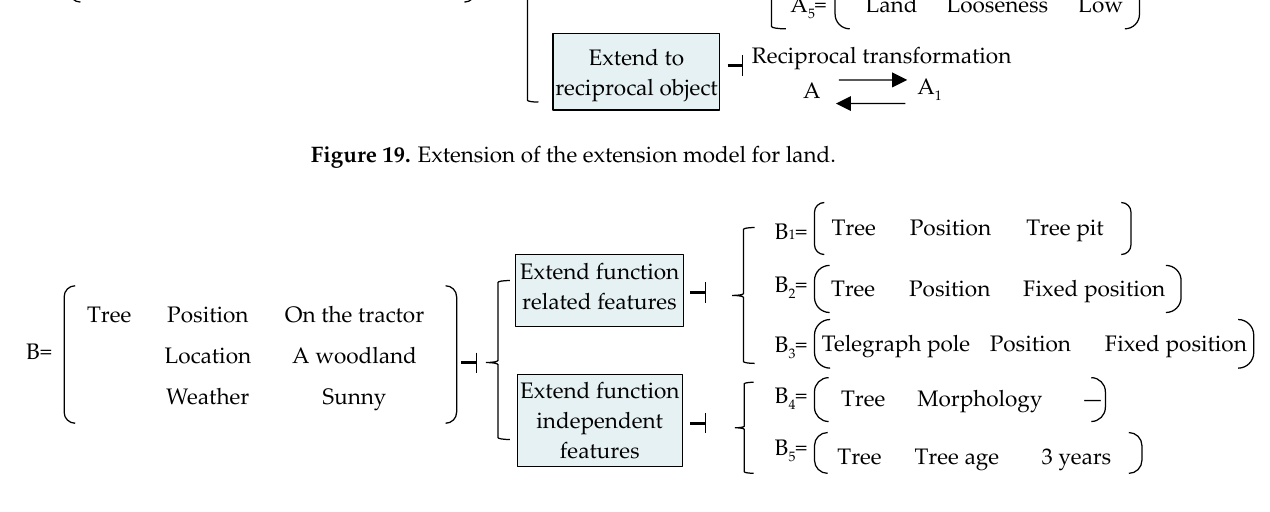
Figure 20. Extension of the extension model for trees.